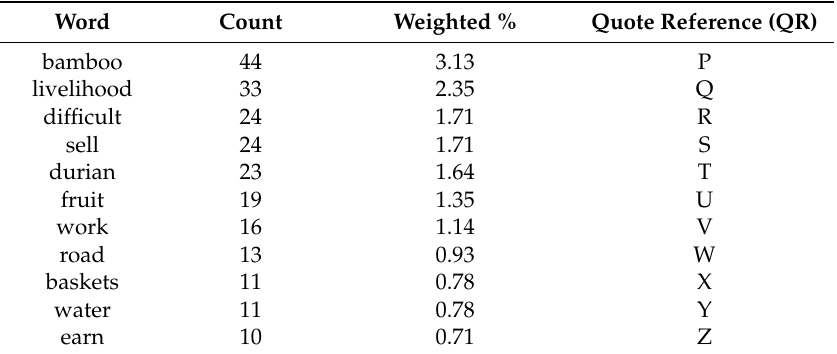
Table 5. Word frequency analysis for livelihoods’ changes and